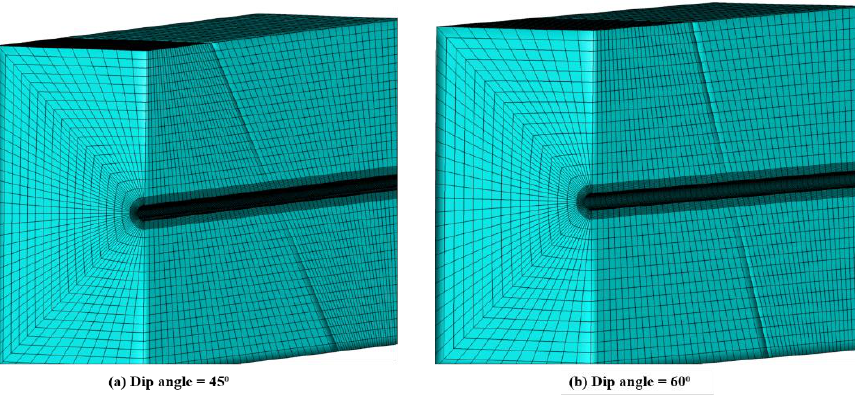
Figure 14. Model and meshing of the tunnel with dip angles of 45° and 60°.